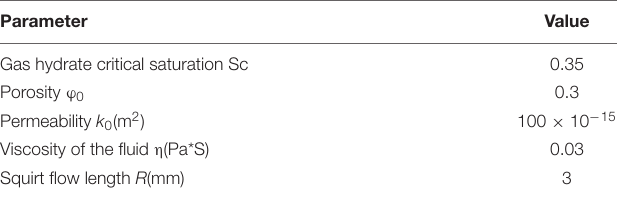
TABLE 2 | Parameters used in the BISQ